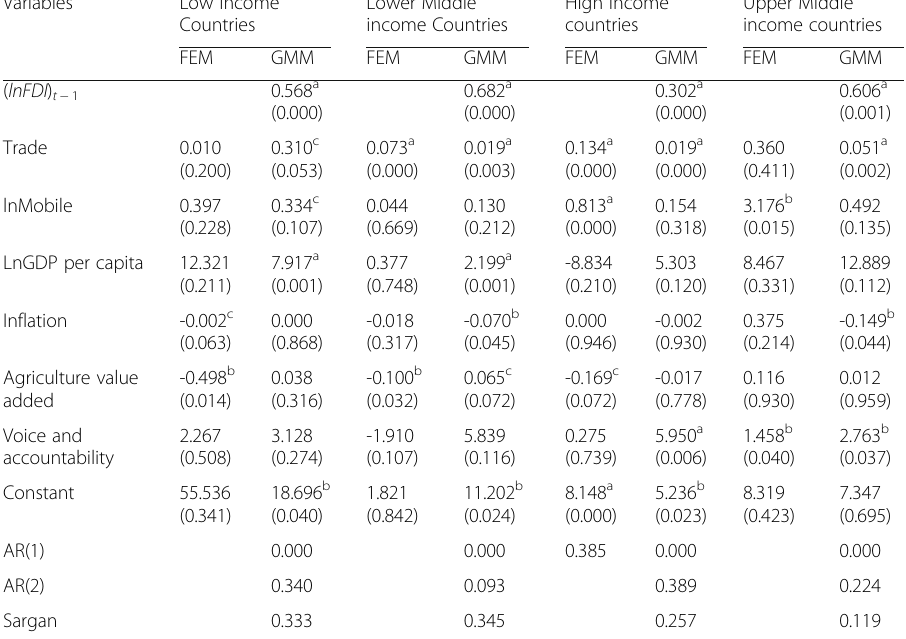
Table 15 Voice and Accountability and